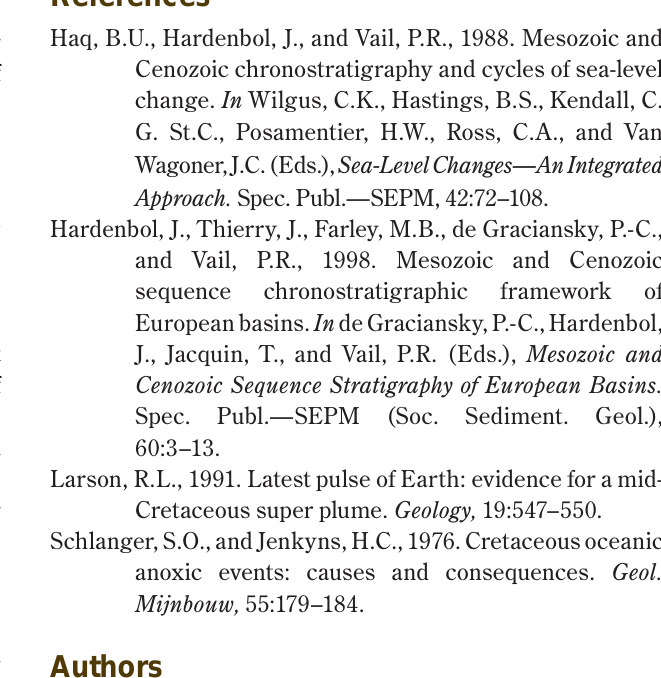
Figure 2. Study areas (presenters) considered during the OAE Sapporo Symposium. 1. Anglo-Paris Basin (A.S. Gale), 2. NW-German Basin (J. Mutterlose), 3. Vocontian Basin (R. Takashima; K. Nagai et al.; K. Okano et al.), 4. Italy (J. Kuroda et al.), 5. Western Interior (M. Leckie et al., B. Sageman et al.), 6. Great Valley (A. Fernando et al., T. Tomosugi et al.), 7. Yezo Basin (H. Ando; K. Kurihara & F. Kawabe), 8. Blake Nose (B. Huber et al., J. Erbacher et al.), and, 9. Demerara Rise (J. Erbacher et al., A. Bornemann & R.D. Norris; P.A. Meyers & J.–G. Yum; A. Forster et al.)